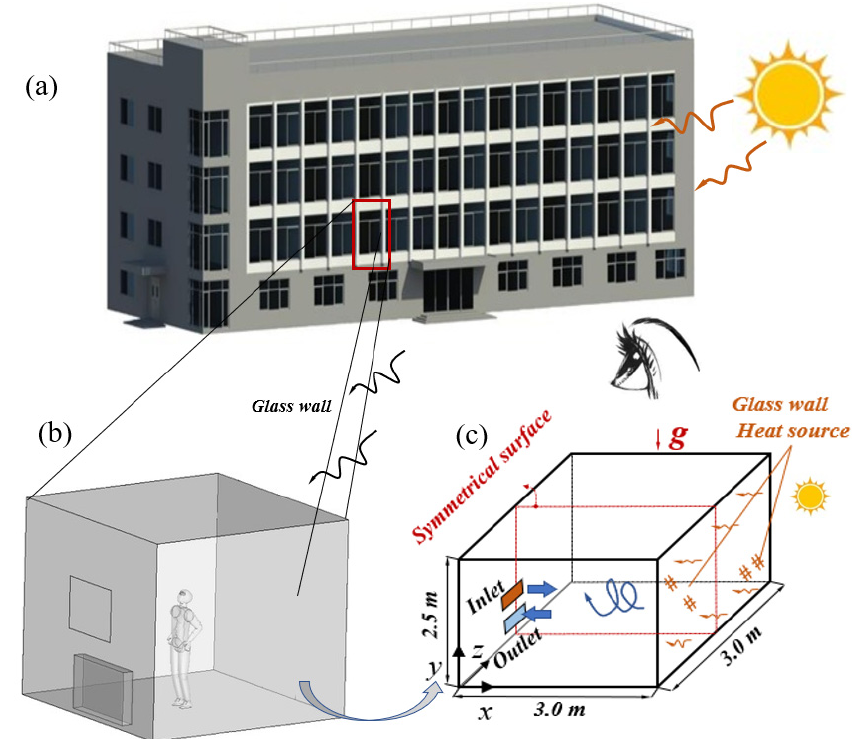
Figure 2. Schematic of ( a ) a typical office building; ( b ) a typical interior structure of a thermal environment; ( c ) a thermal environment simulation model.